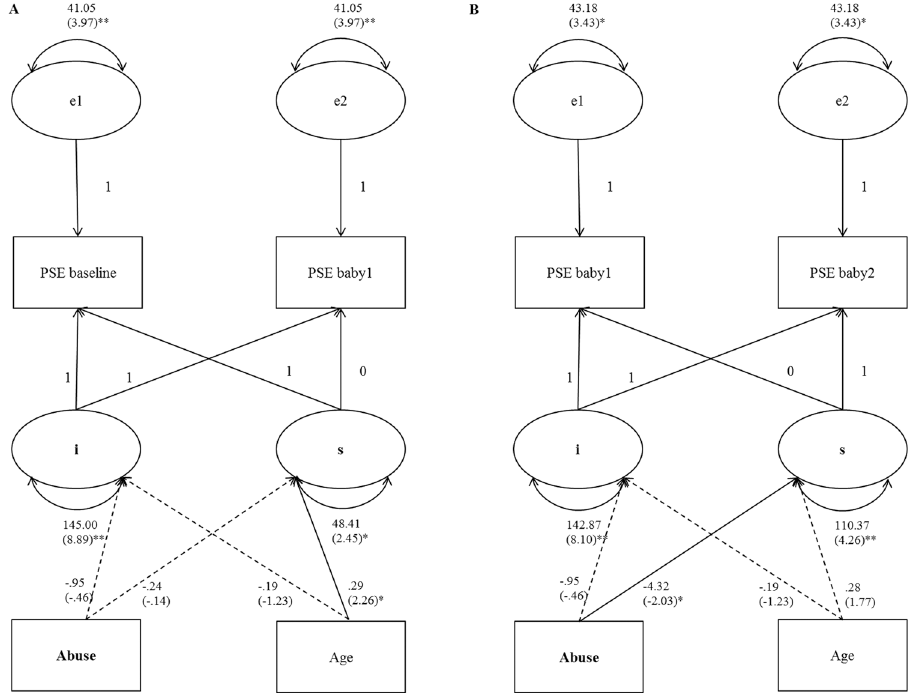
Fig 2. Results of fitted latent growth curve models for PSE during the Cry Response Task with abuse as predictor. (A) Model 1: Predicting changes in PSE from baseline to baby 1. (B) Predicting changes in PSE from baby1 to baby2. PSE = Parenting Self-Efficacy; e1 and e2 = residuals; i = intercept; s = slope. Standardized path coefficients ( z -scores) are provided in parentheses. * p < .05. ** p < .001.